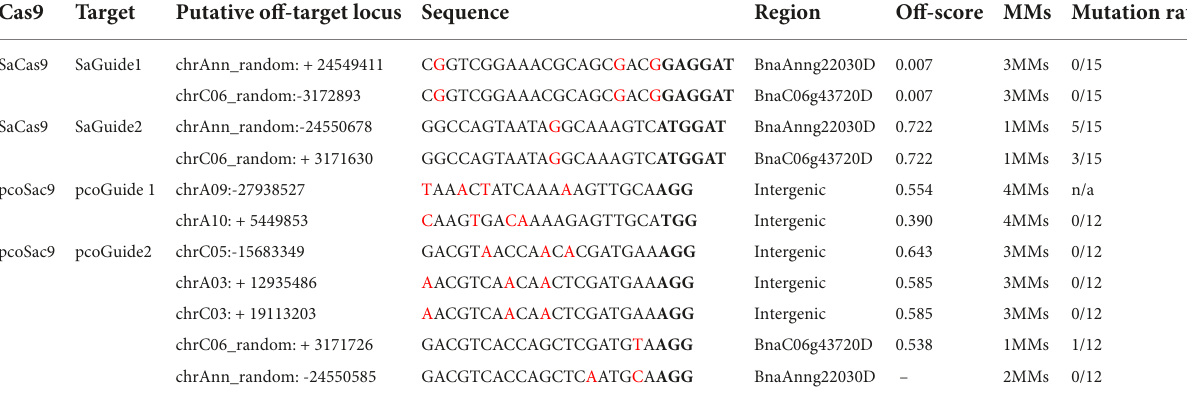
TABLE 1 Detection of mutations at potential CRISPR/Cas9 off-target sites in the T0